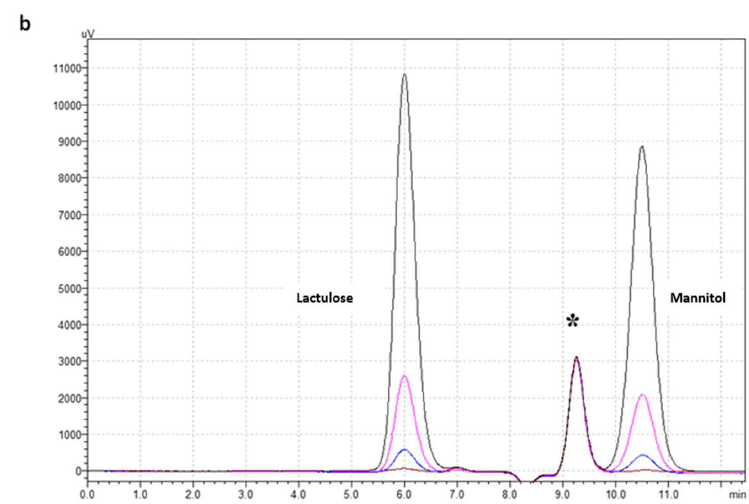
Figure 1. Chromatographic separation of lactulose and mannitol in standard solutions. Chromatograms depict ( a ) the resolution and peak separation of standard solutions containing 250 µg mL −1 lactulose and mannitol at 5.7 and 10.1 min, respectively. ( b ) Each sugar was eluted at the same retention time following injection of a range of different concentrations of standard solutions that contained 500 µg mL −1 (black), 125 µg mL −1 (pink), 31.3 µg mL −1 (blue), and 3.9 µg mL −1 (brown) lactulose and mannitol. A consistent residual peak before that of the mannitol peak from the diluent (water) is shown with an asterisk.